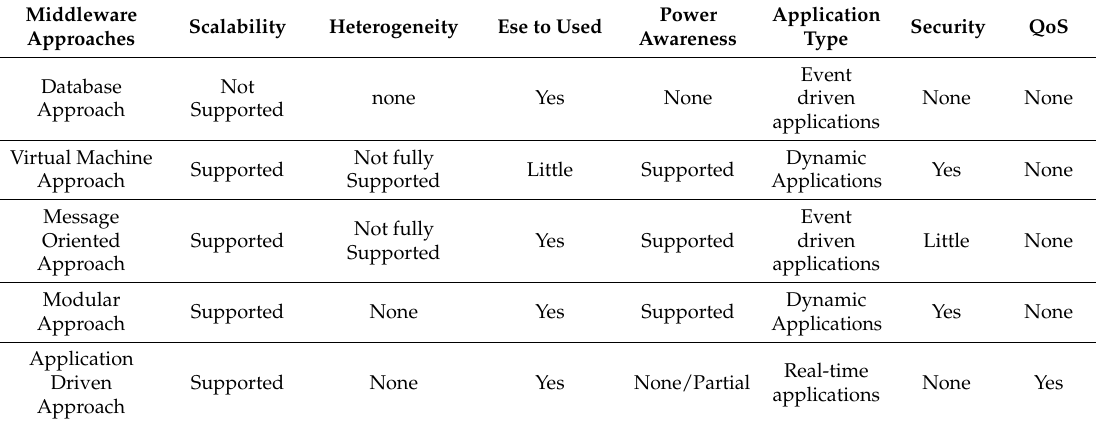
Table 1. A Comparison of Different Middleware Architectures